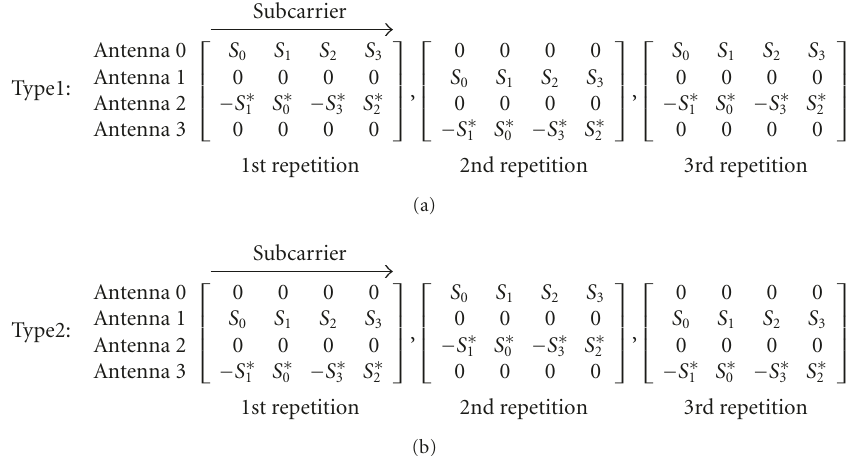
Figure 5: Modified SFBC + FSTD for PHICH with four transmit antennas on downlink.